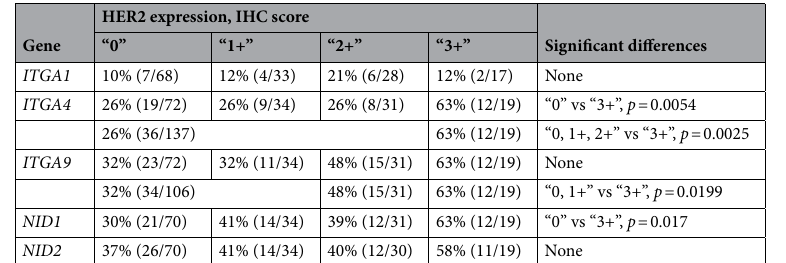
HER2 expression, IHC score Gene